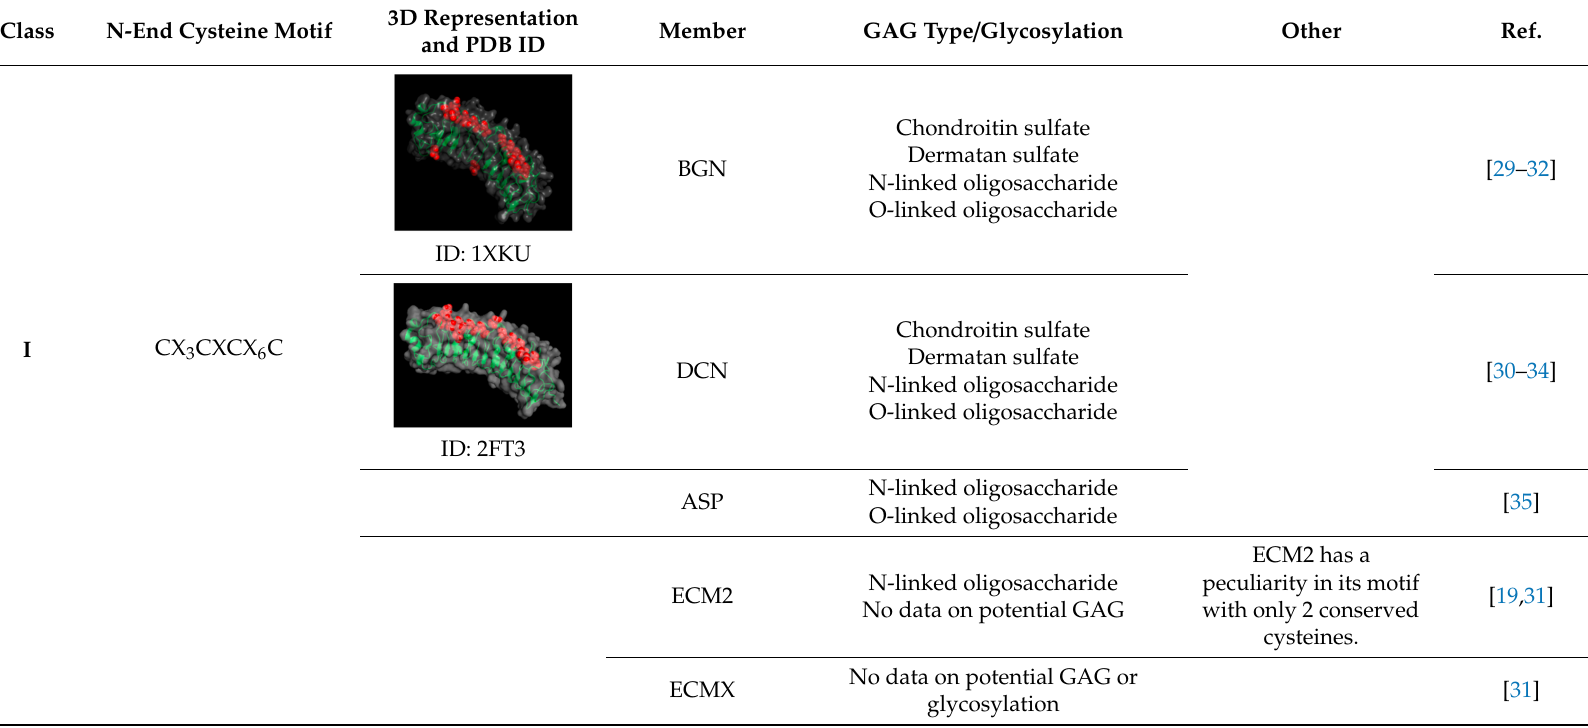
Table 1. Classification of the SLRP family in five classes; BGN: Biglycan; DCN: Decorin; ASP: Asporin; ECM2: Extracellular Matrix Protein 2; ECMX: Extracellular Matrix Protein X; LUM: Lumican; KTN: Keratocan; FMOD: Fibromodulin; OMD: Osteomodulin; PRELP: Proline / arginine-rich end leucine-rich repeat protein; EPN: Epiphycan; OGN: Osteoglycin; OPTC: Opticin; CHAD: Chondroadherin; NYX: Nyctalopin; TSK: Tsukushi; PODN: Podocan; PODNL: Podocan-like